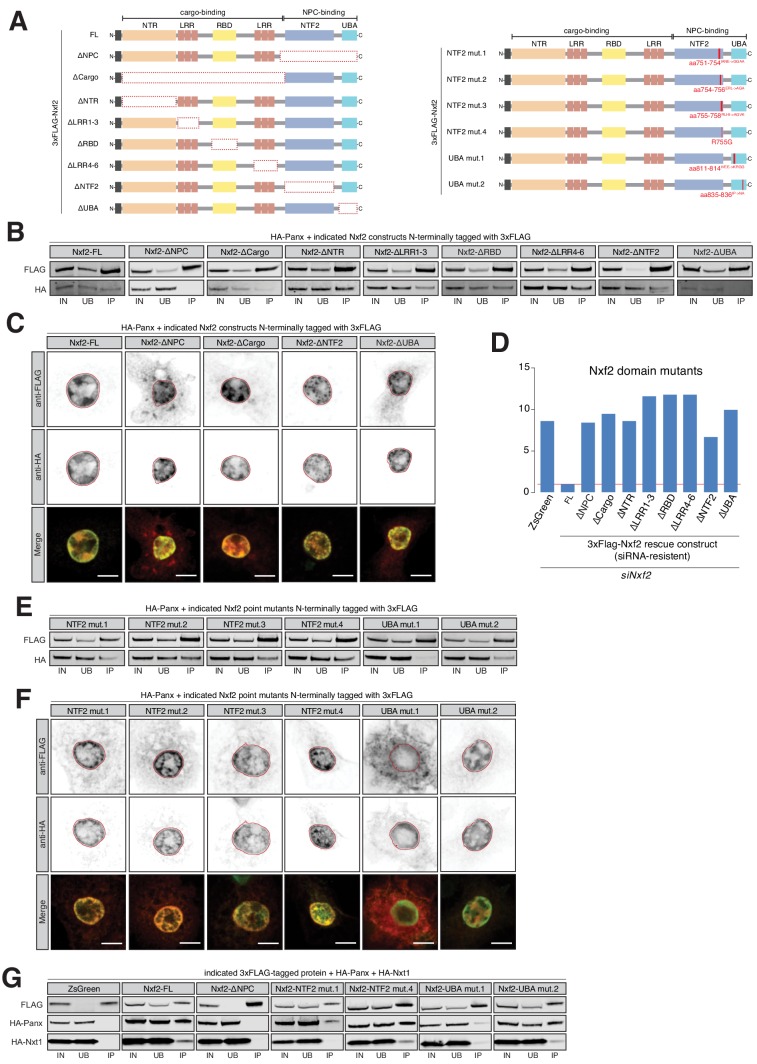
Interaction between Nxf2 and Panx is required for proper transposon silencing.(A) Cartoons displaying the Nxf2 protein structure and domain mutants and altered residues used in panels (B) through (H). (B) Western blot analyses of FLAG-tag co-immunoprecipitation from lysates of S2 cells transfected with the indicated expression constructs (IN, input; UB, unbound; IP, immunoprecipitate). (C) Expression and localization of the indicated Nxf2 domain mutant (3xFLAG-tagged, top, shown in red in the merge) and full-length Panx (HA-tagged, bottom, shown in green in the merge) expression constructs in transfected S2 cells are shown by immunofluorescence. Lamin staining (red lines) was used to draw the outline of the nuclear envelope. Scale bar, 5 µm. (D) Bar graphs showing fold changes in steady-state RNA levels of the mdg1 transposon in total RNA from OSCs transfected with siRNAs against and Nxf2 and the indicated siRNA-resistant expression constructs (relative to full-length rescue construct and normalized to rp49; n = 1). (E) As in (B) but showing co-immunoprecipitation of the indicated Nxf2 point mutants. (F) As in (C) but showing the expression and localization of Nxf2 point mutants. (G) As in (B) but showing co-immunoprecipitation of HA-tagged Panx and Nxt1 with the indicated Nxf2 point mutants.